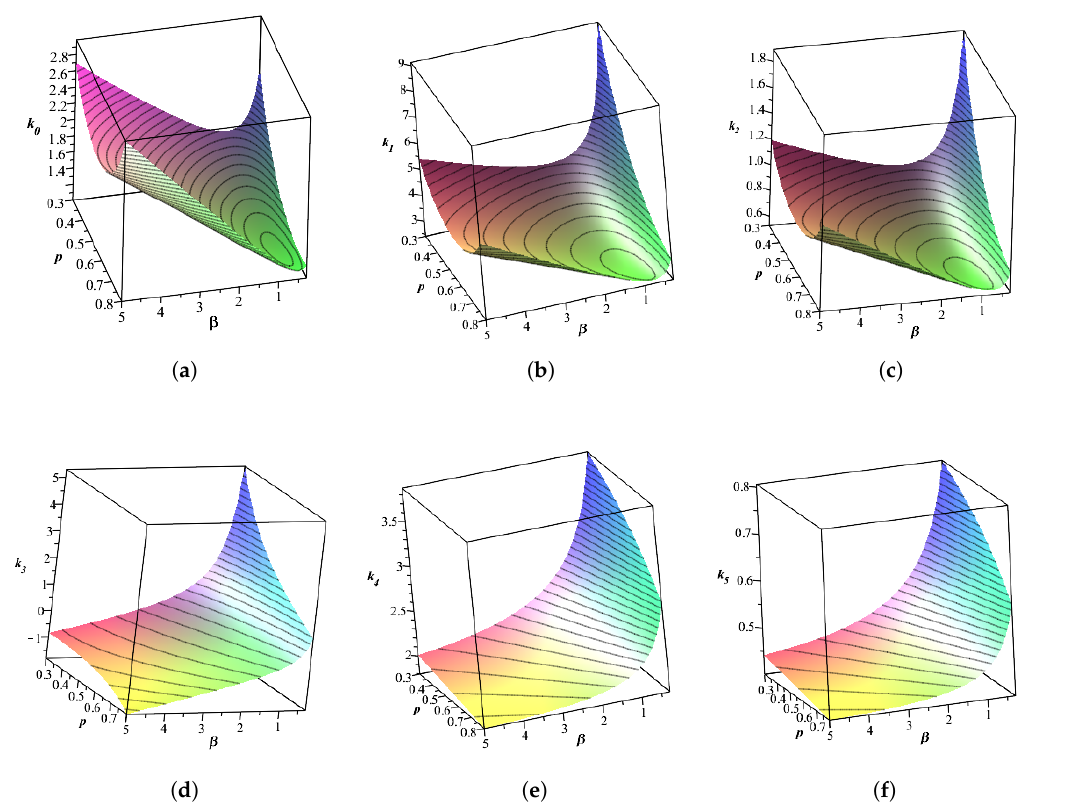
Figure 1. The boxes ( a – d ) show the areas of stability and instability in the space of parameters p e , β , κ for δ = ( 1,1,0,0 ) by visualizing the neutral surface κ = k j , j = 0,1,2,3, where k j = ( 0 ) K ( (cid:101) f j , p e , β ,1,1 ) / κ ∗ ( 1,1 ) , j = 0,1,2, k 3 = max ( 0, K ( (cid:101) f 3 , p e , β ,1,1 )) , (cid:101) f m = a m sin ( ξ − c m τ ) , m = 0,1,2,3, a 0 = c 0 = 0, a 1 = 3, a 2 = 2, a 3 = 3.5, c 1 = 0.8, c 2 = c 3 = 1.2. Note that min β c ∗ ( p e , β ,1,1 ) = 1. Hence, c 1 < c ∗ for every p e and β while c 2 > c ∗ for some p e and β . Additionally, for every box in this figure, ν 1 = ν 2 = 1 and a = A . Thus, the box ( a ) corresponds to the case of homogeneity and shows in